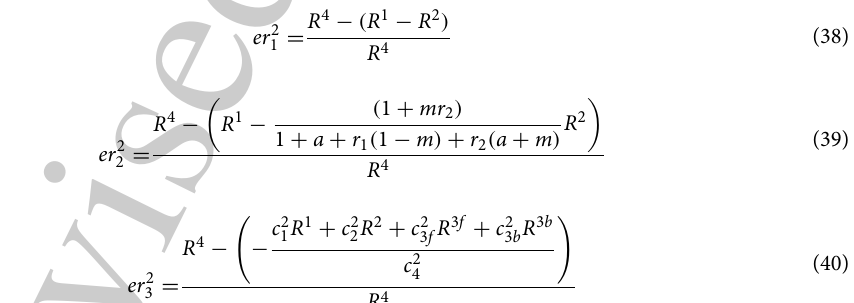
IgG IgG . FcRn e and C e